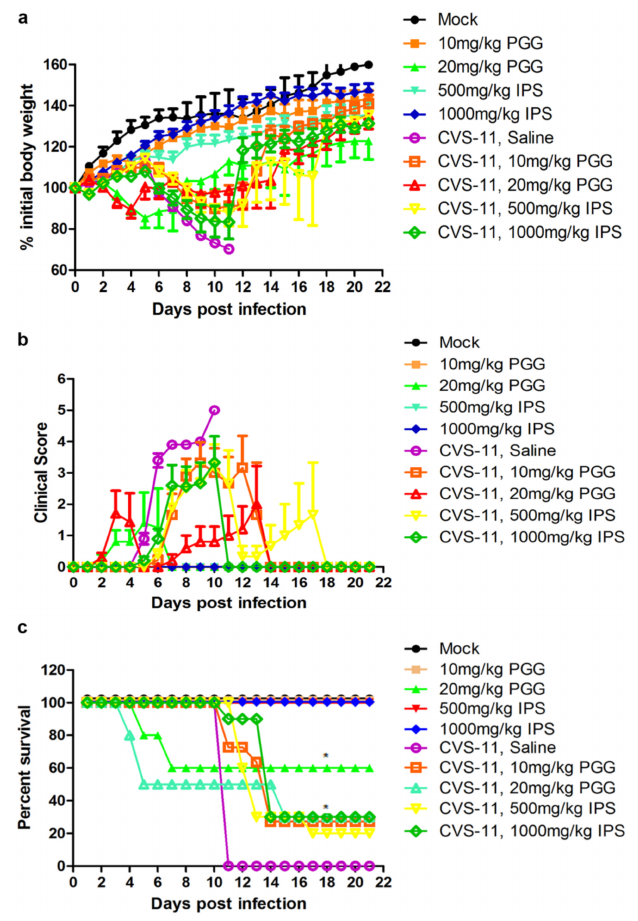
Figure 8. PGG alleviates the clinical symptoms and reduces the mortality of RABV-infected mice. Kunming mice ( n = 10 or 11) were challenged intramuscularly (IM) with 10 LD 50 of lethal CVS-11 and treated with PGG or IPS (indicated concentration) by intraperitioneal (IP) injection 1 h p.i. and given daily by IP injection for 3 day, and observed for body weight change ( a ); clinical signs ( b ); and survival ( c ) for 21 day. (* p < 0.05;